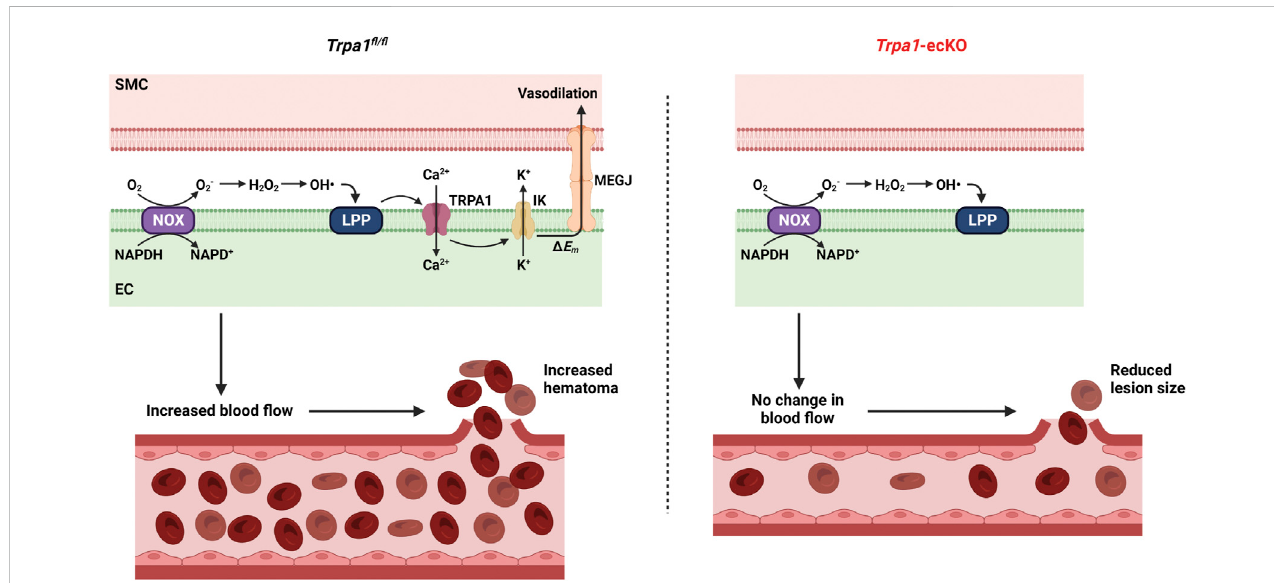
FIGURE 4 Hypothetical model of TRPA1 -induced hematoma expansion . Severe hypertension increases NOX-dependent superoxide (O 2 − ) generation in endothelial cells. O 2 − is dismutased to hydrogen peroxide (H 2 O 2 ), which undergoes the Fenton reaction to produce hydroxyl radicals (OH membrane lipids to generate lipid peroxidation products (LPP) which activate TRPA1 channels. Ca 2+ in fl ux through TRPA1 channels stimulates K + ef fl ux through intermediate conductance Ca 2+ -activated K + (IK) channels leading to plasma membrane hyperpolarization ( Δ E m ). Hyperpolarization spreads to smooth muscle cells through myoendothelial gap junctions (MEGJ), resulting in vasodilation and increased blood fl ow, leading to a larger hematoma when vascular wall integrity is compromised. Trpa1 -ecKO don ’ t experience ROS-induced vasodilation, resulting in smaller